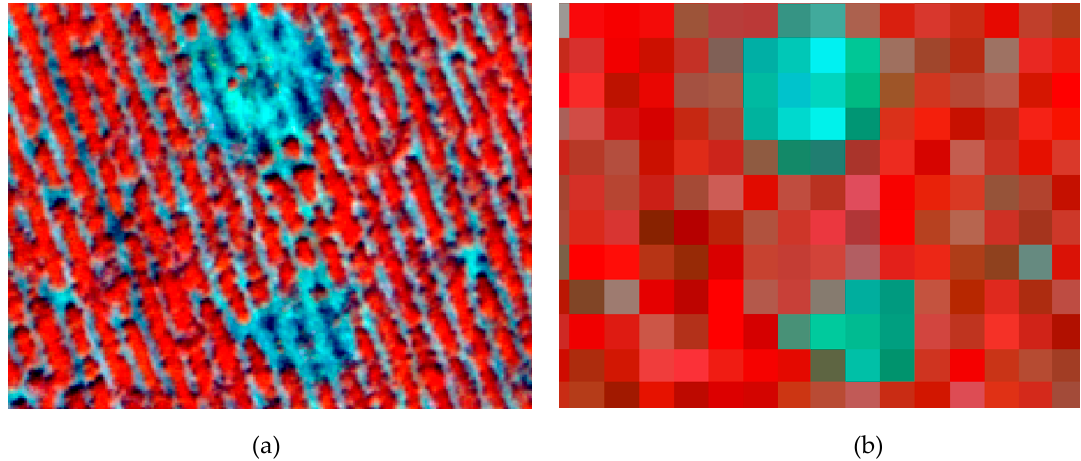
Figure 10. The cotton root rot (CRR) infested cotton shown in color-infrared composites with different resolutions: ( a ) 0.076 m/pixel; and ( b ) 1 m/pixel (Scale 1:200).